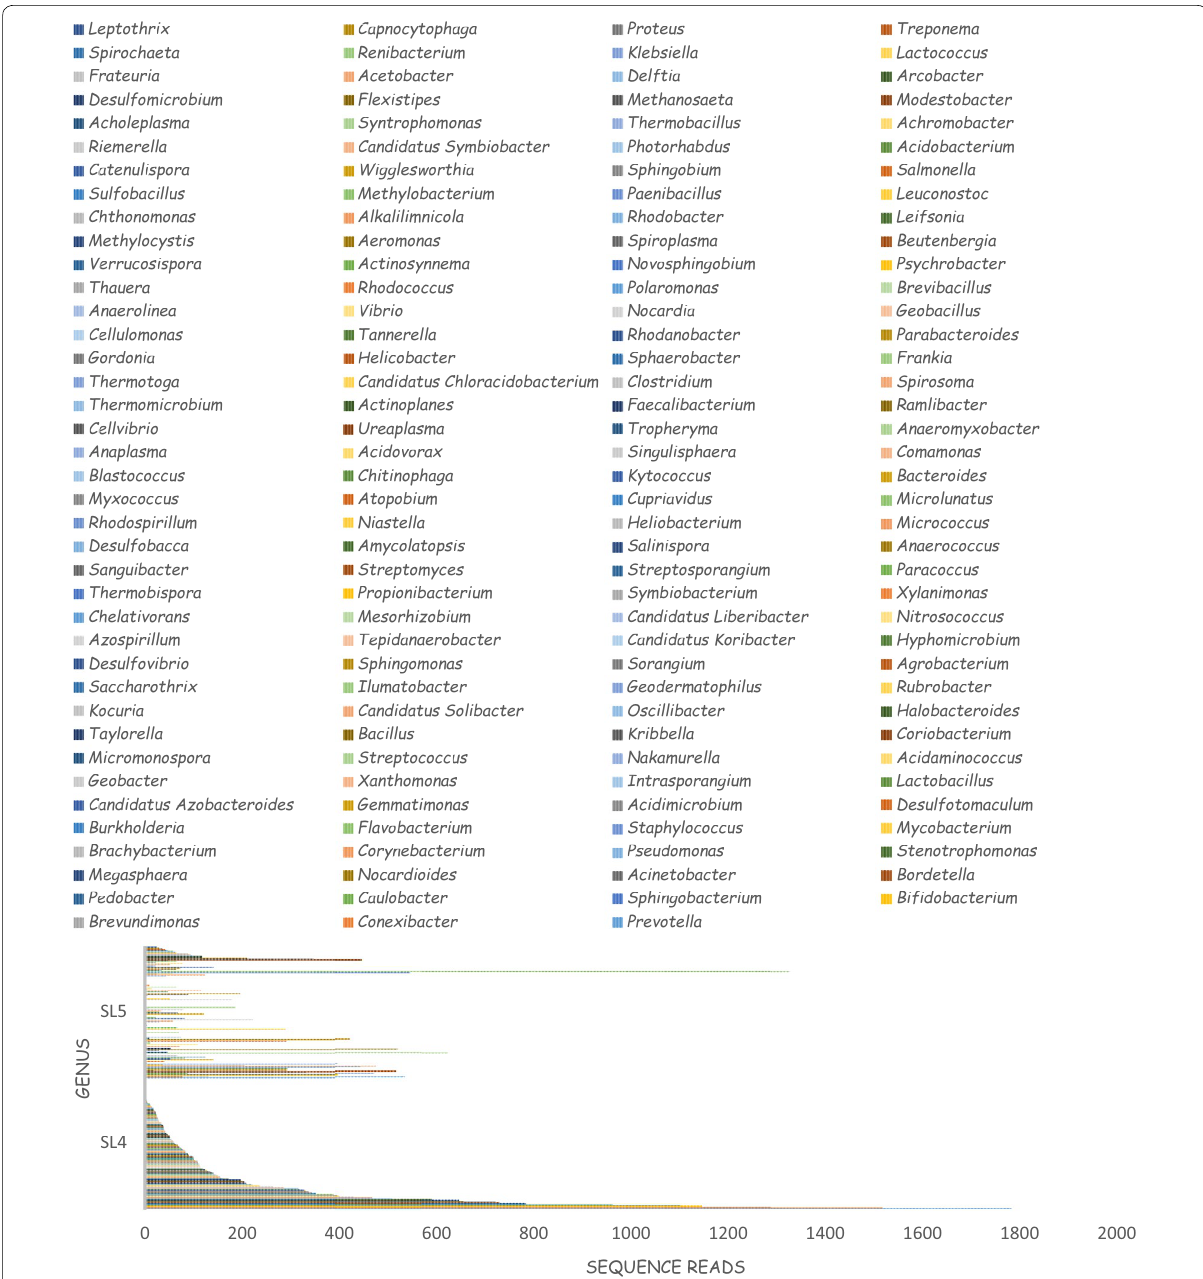
Fig. 3 Comparative taxonomic profile of SL4 and SL5 metagenomes at genus level, computed by EDGE Bioinformatics. Unclassified reads were not used. Only genera with 10 sequence reads were used for the ≥